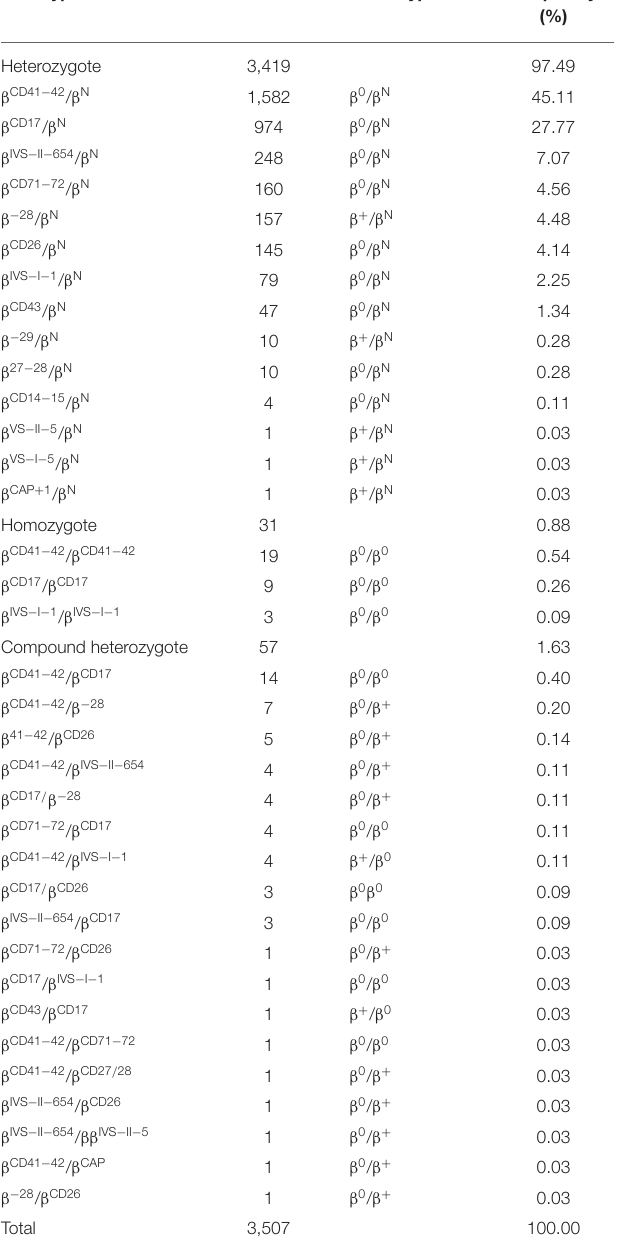
TABLE 2 | Distribution of genotypes among the 3,507 β -thalassemia children in Guangxi. Genotype Cases Phenotype